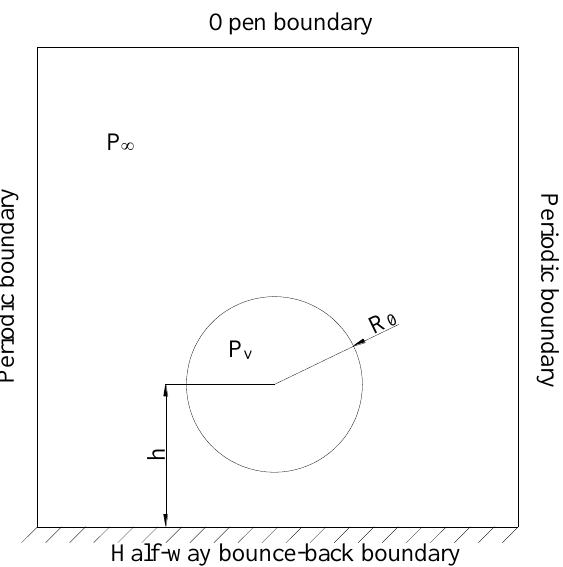
Figure 4. Computational layout for the cavitation bubble collapse near a straight wall.